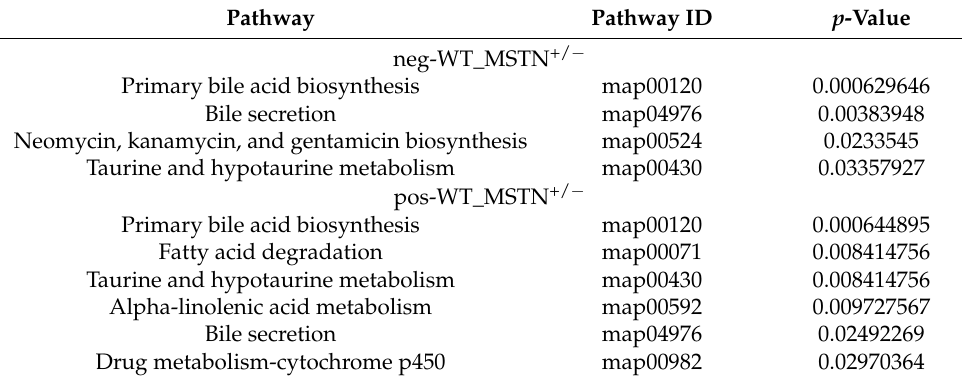
Table 2. Enrichment of metabolic pathways based on differentially expressed metabolites of liver in MSTN +/ − and WT cattle.